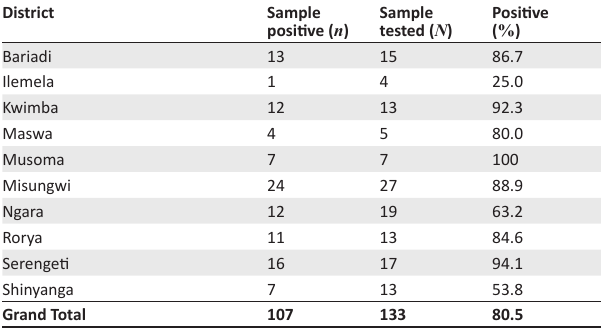
TABLE 1: Overall positive sera for 3ABC-FMDV antibodies per district of lake zone. District